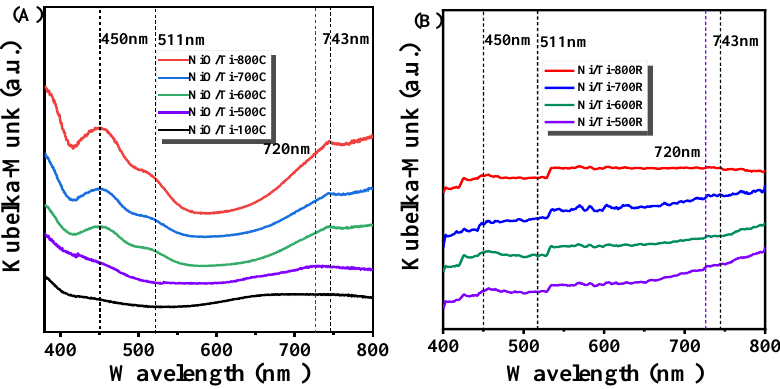
Figure 1. UV−vis diffuse reflection spectrum of the samples annealing ( A ) and reduce ( B ). Figure 1. UV − vis diffuse reflection spectrum of the samples annealing ( A ) and reduce ( B